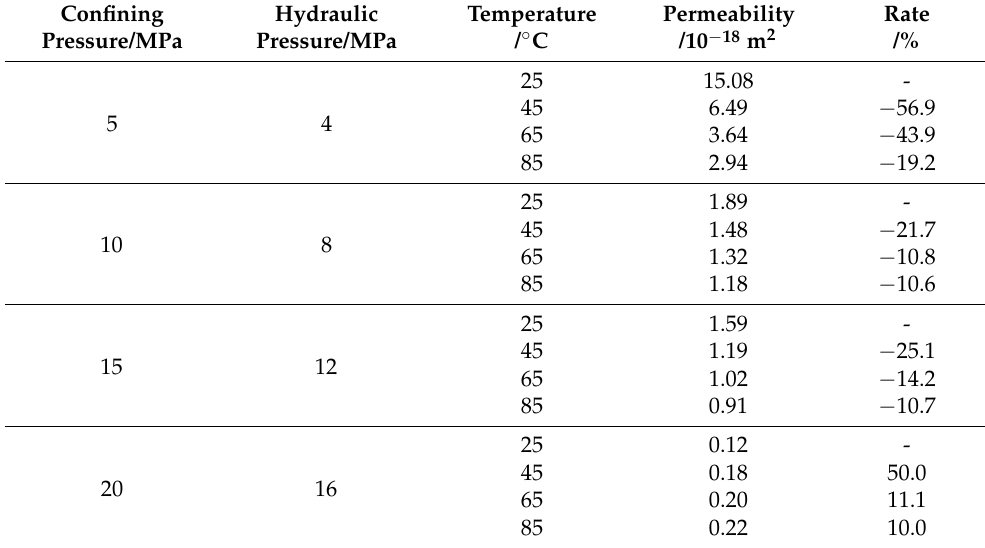
Table 2. Permeability increase of coal specimens at different temperatures.